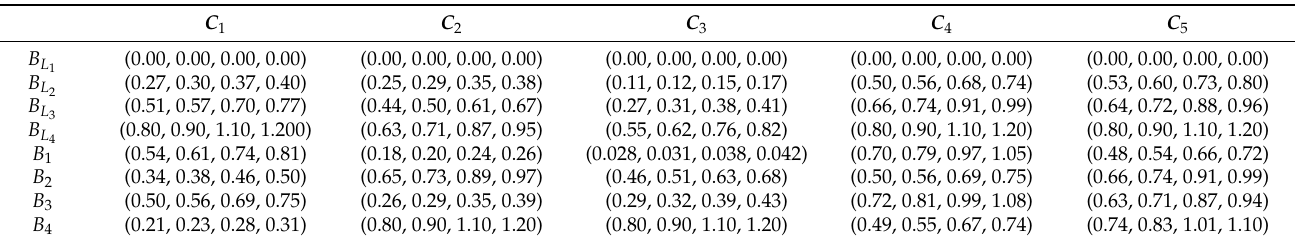
Table 4. Fuzzy decision-making matrix.